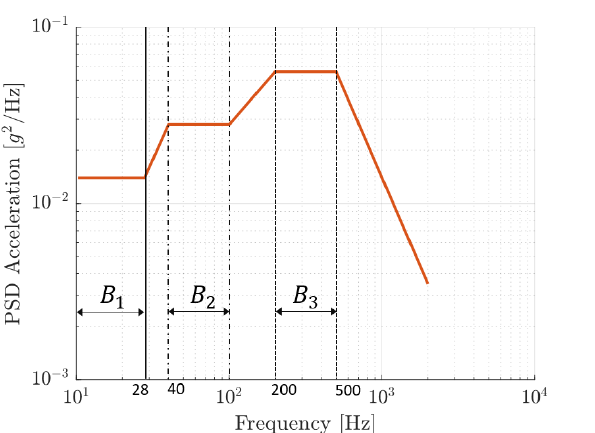
Figure 7. PSD of the acceleration based on the standard specification RTCA-DO-160 CAT S curve E [22]. Three characteristic frequency bands are defined and